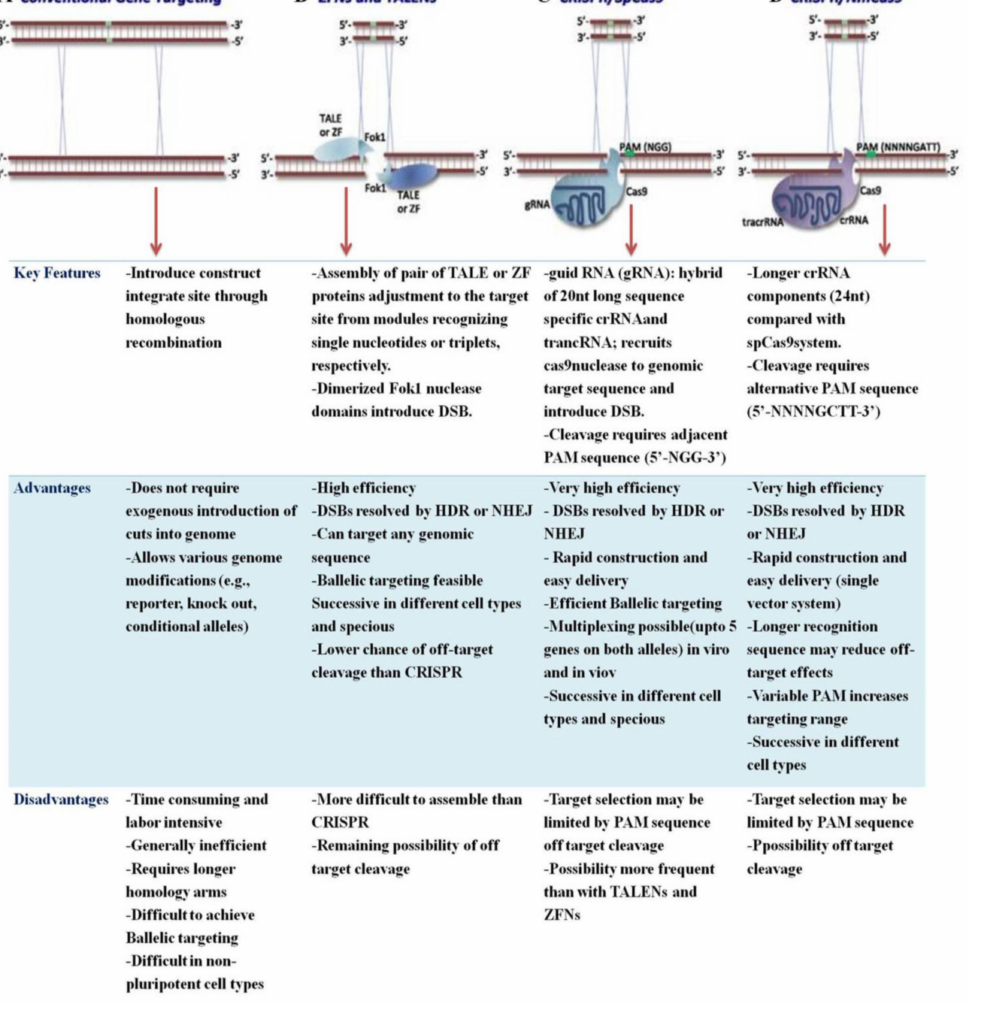
Figure 2. The advantages and disadvantages of the CRISPR/Cas9 system over other approaches for genome editing. ( A ). Conventional gene targeting. ( B ). ZNFs and TALENs. ( C ). CRISPR/SpCas9. ( D ). CRISPR/NmCas9. The red arrow indicates the corresponding gene editing method with its features, advantages, and